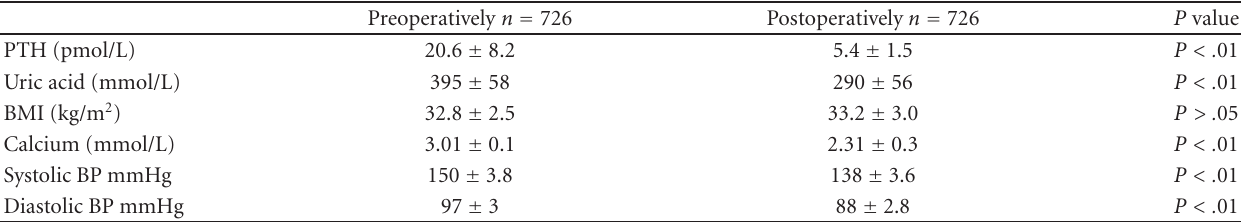
Table 2: Preoperative and postoperative biochemical data, BMI, and arterial blood pressure in hypertensive patients with primary hyperparathyroidism. Results are presented as mean values ±